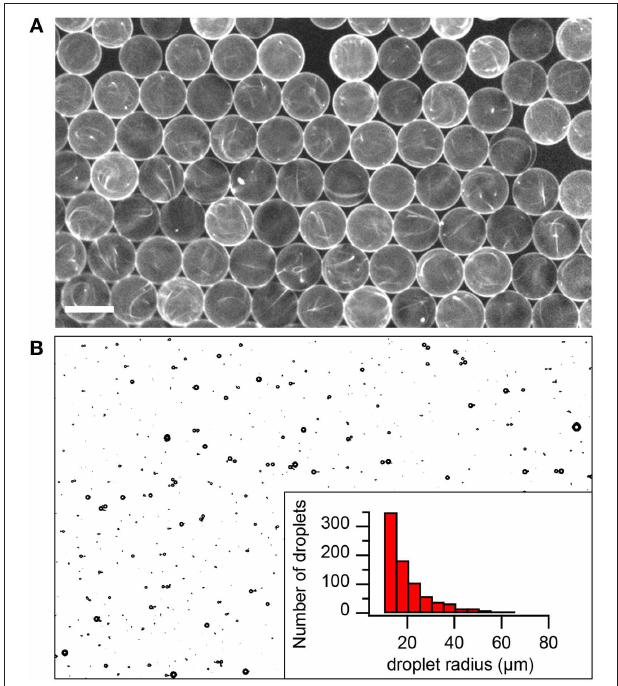
FIGURE 2 | Sources of heterogeneity of the active emulsions. (A) Heterogeneous composition of monodisperse active droplets prepared using microfluidic techniques and dispersed in an isotropic oil. The ruler is 100 µ m long. (B) Size distribution of droplets in a typical active nematic